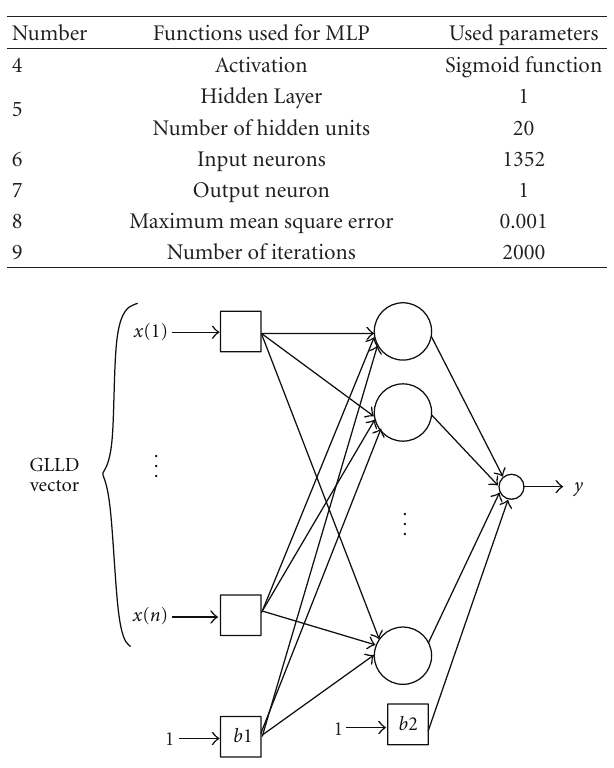
Figure 8: MLP classifier architecture.